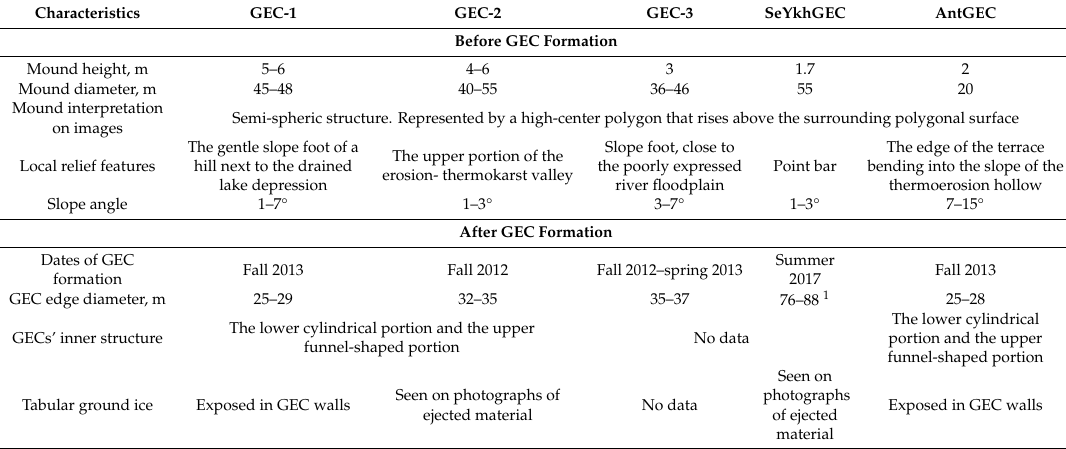
Table 3. Comparison of geomorphic and environmental characteristics of studied landforms.